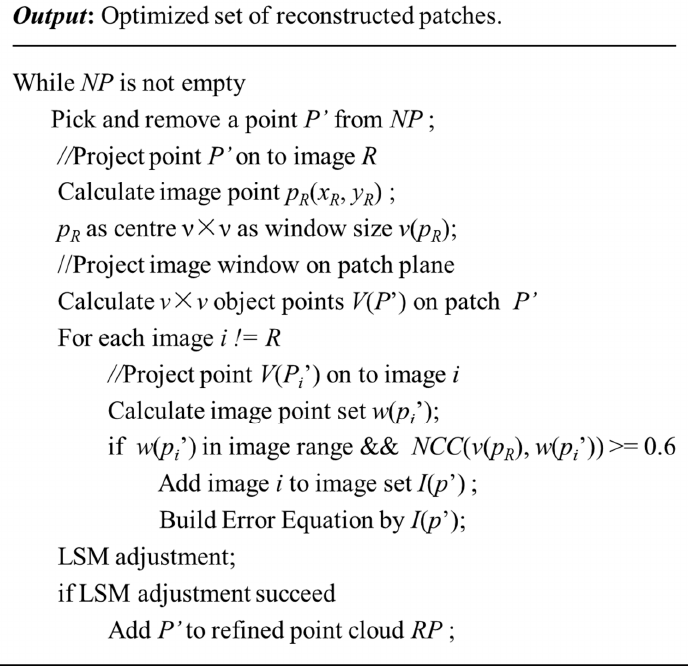
Figure 3. Process of point cloud optimization